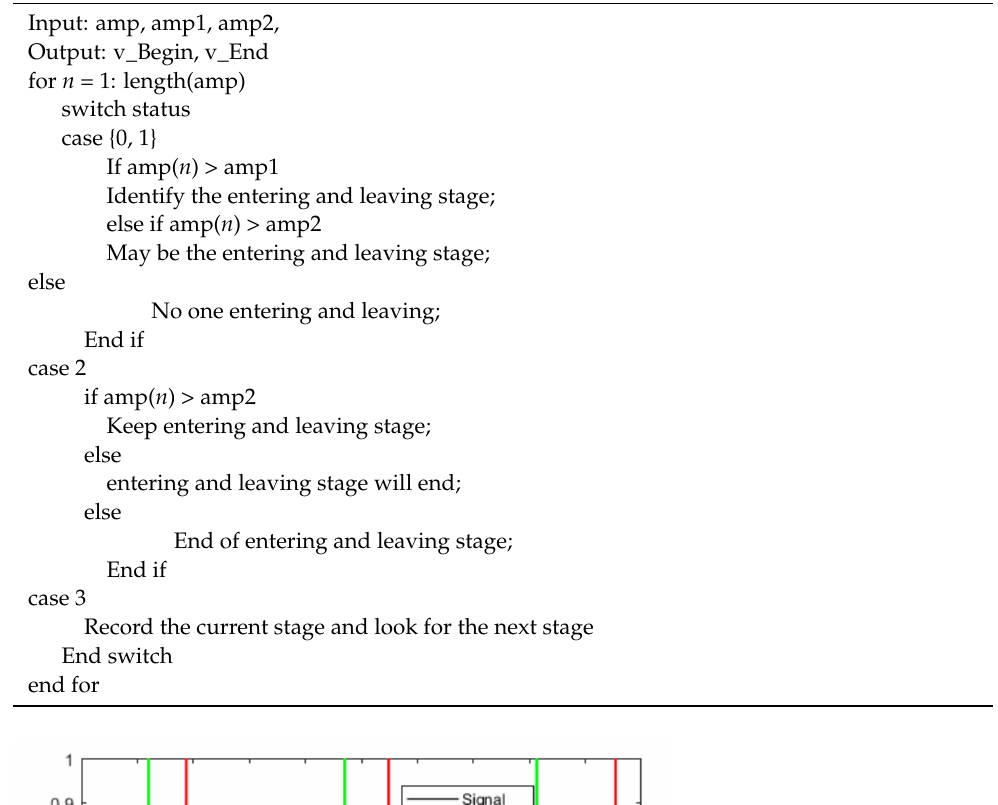
Algorithm 1: Determination of the start and end times.